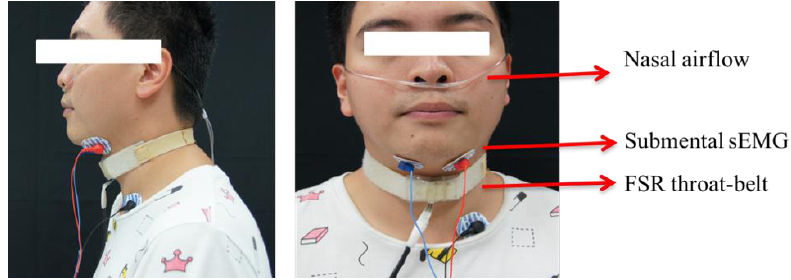
Figure 2. The usage of FSR, submental surface electromyography (sEMG), and nasal airflow cannula.